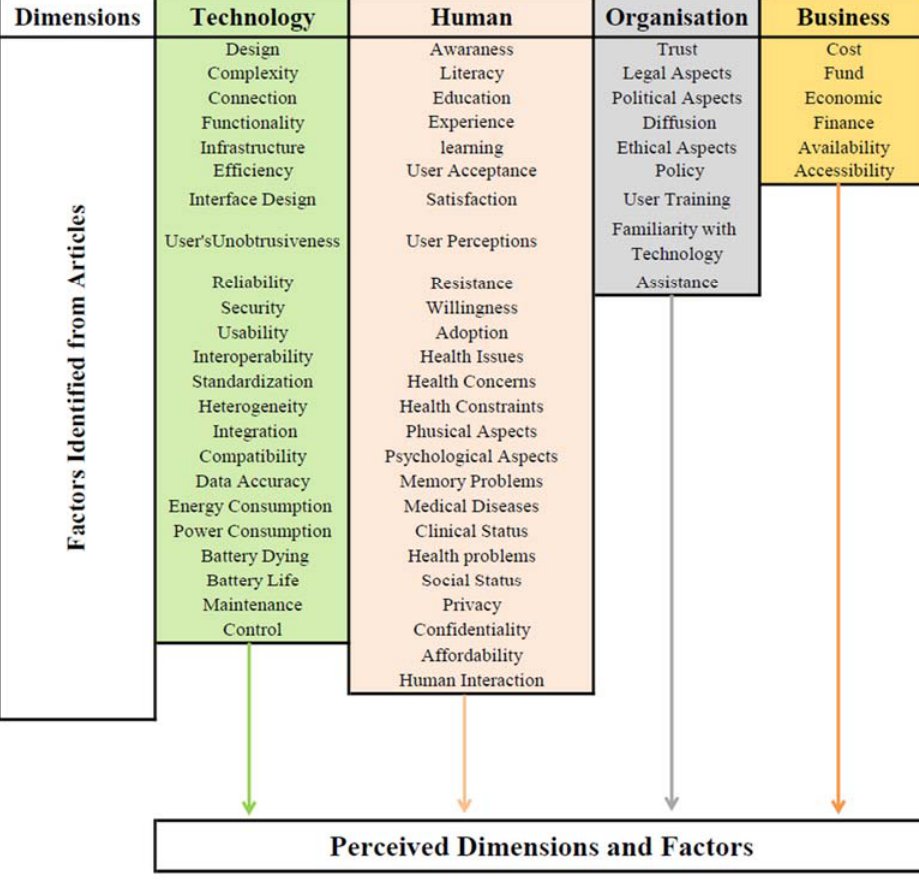
Figure 2. Map of initial dimensions and factors.